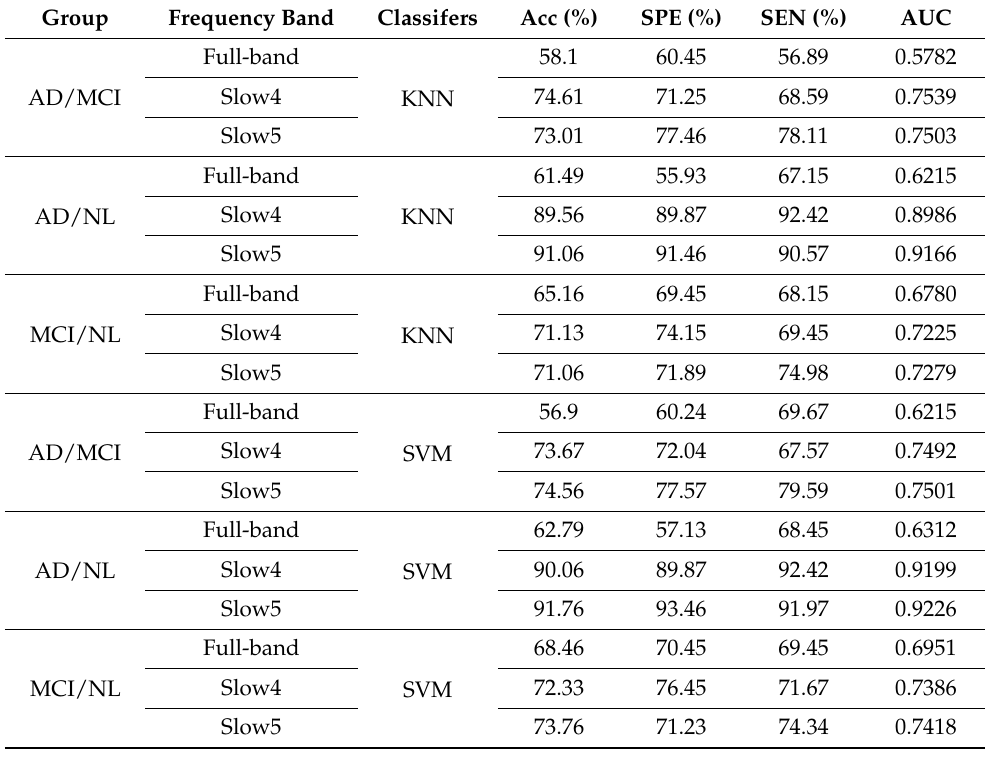
Table 4. Compares the performance of KNN and SVM model using slow4, slow5, and full-band features with traditional machine learning models.